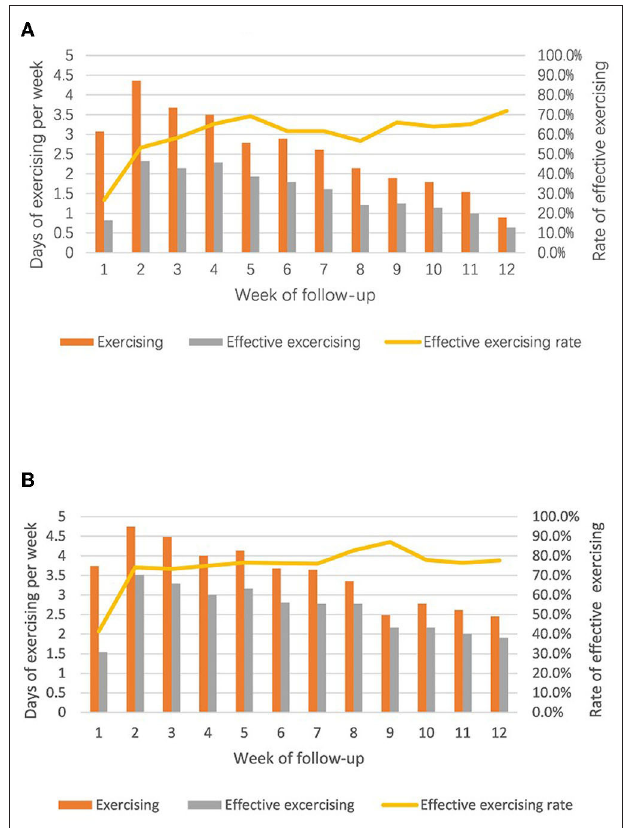
FIGURE 2 | Comparisons of exercising performance between two groups (A) control group, unsupervised; (B) intervention group, supervised.